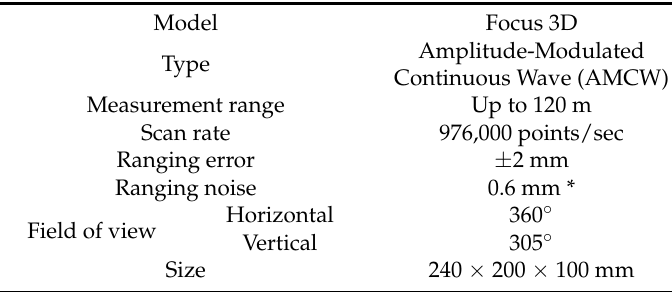
Table 4. Specifications of the terrestrial laser